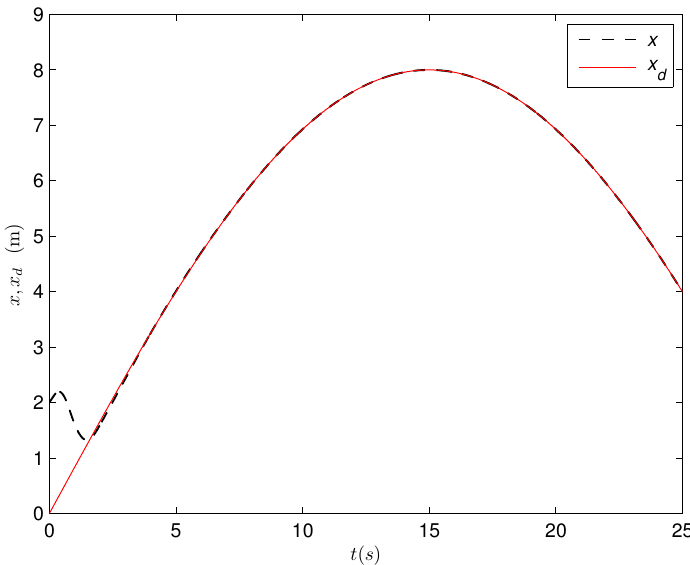
Figure 2. Surge displacement(output feedback barrier adaptive control).